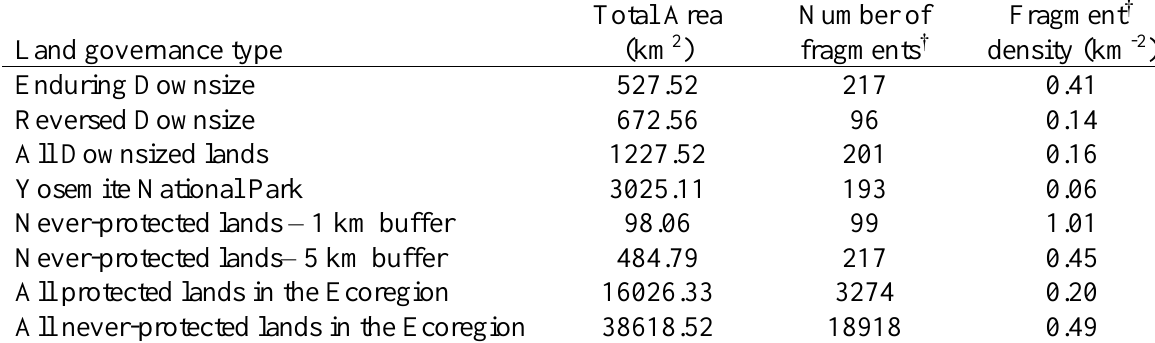
Table A1.16: Fragment density calculations at three spatial scales for all land cover types